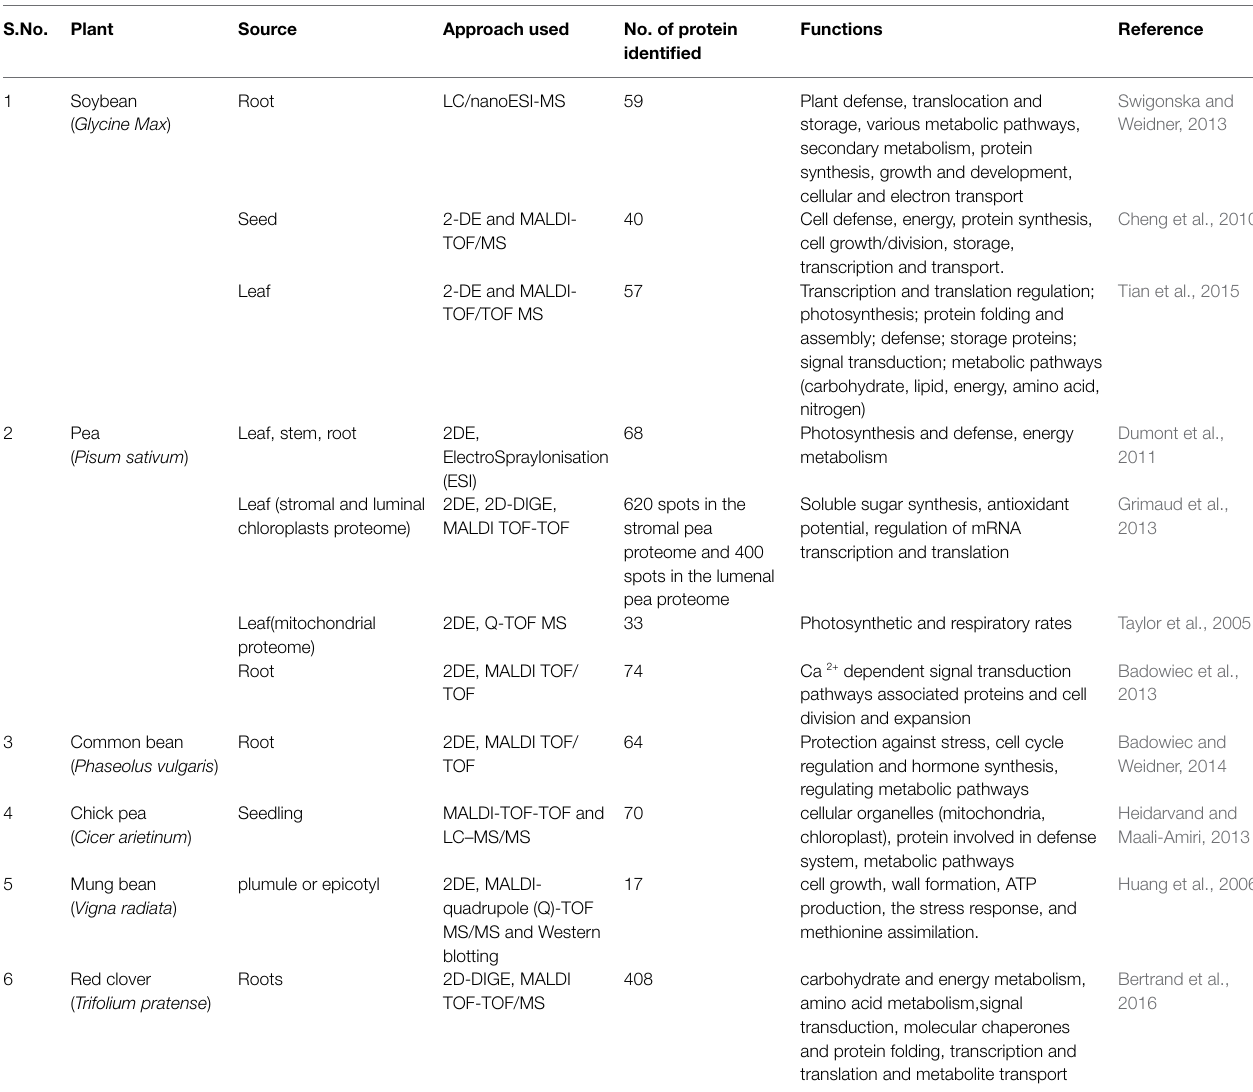
TABLE 4 | Proteomic studies related to cold stress conducted in various legumes. S.No.